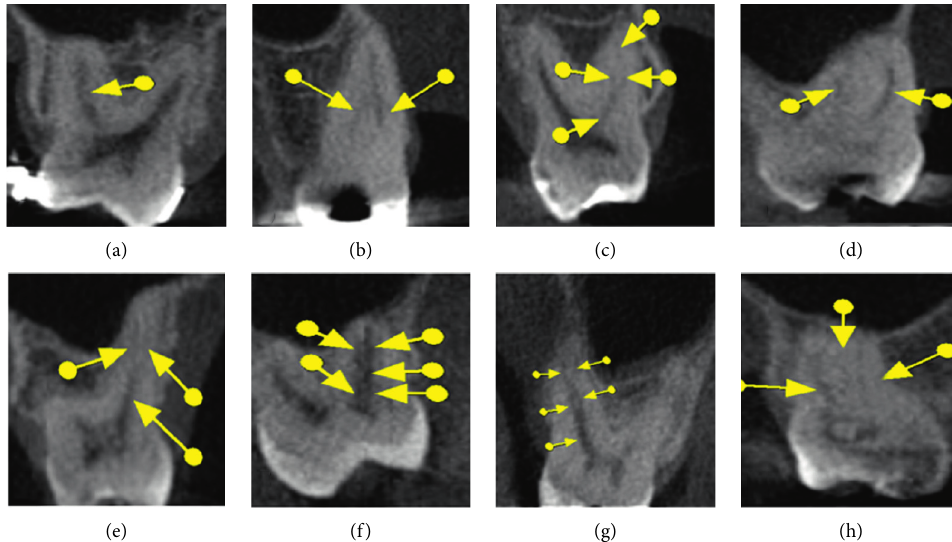
Figure 4: Coronal sections showing the different morphological types proposed by Vertucci [15]: (a) type I, (b) type II, (c) type III, (d) type IV, (e) type V, (f) type VI, (g) type VII, and (h) type VIII. Table 3: Prevalence of morphological root canal types according to the classifications proposed by Weine et al. [14] and Vertucci [15]. Mesiobuccal Distobuccal Palatal Classification Prevalence (%) Prevalence (%) Prevalence (%) Weine et al . [14] Type